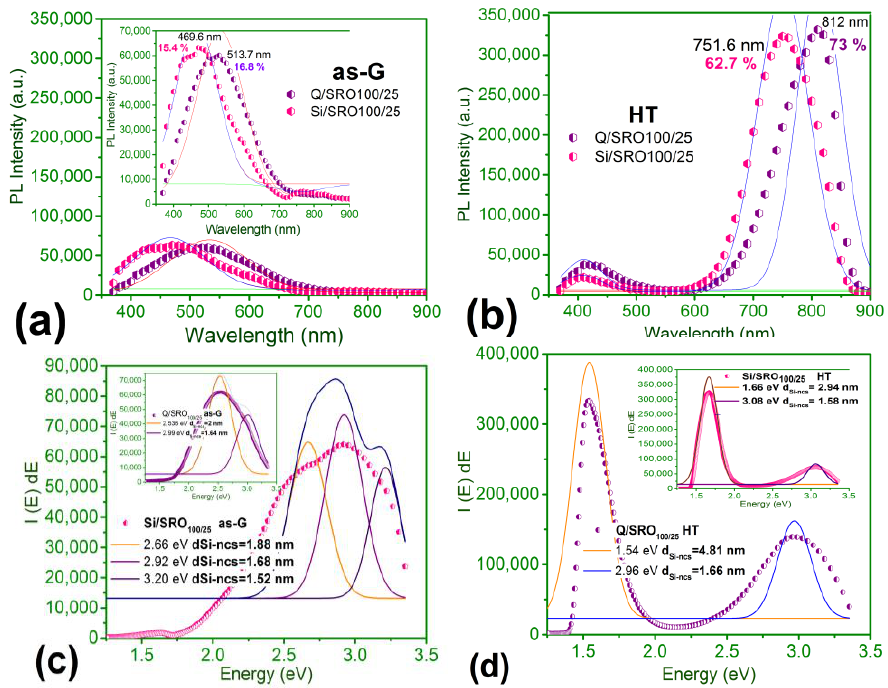
Figure 12. Photoluminescence of the SRO 100 / 25 films deposited by the HFCVD system ( a ) and ( c ) as-G and ( b ) and ( d ) with HT Table 5. Estimated values of the Eg opt and diameters of the Si-ncs calculated by the absorbance of the SRO films.